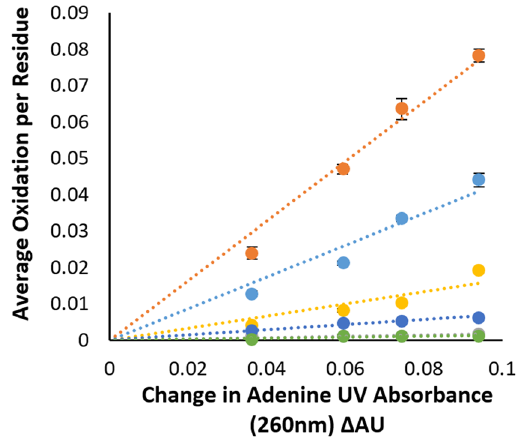
Figure 1. Representative HR-HRPF regressions for five residues from lysozyme after multi-point HR-HRPF performed in triplicate (mean ± SD plotted; error bars obscured by data markers). The levels of oxidation vary linearly with the available hydroxyl radical dose, measured by adenine dosimetry; reactivity is measured as the slope of the regression. Orange - Trp123, light blue – Trp111, yellow – Phe34, dark blue – Asn37, and green –